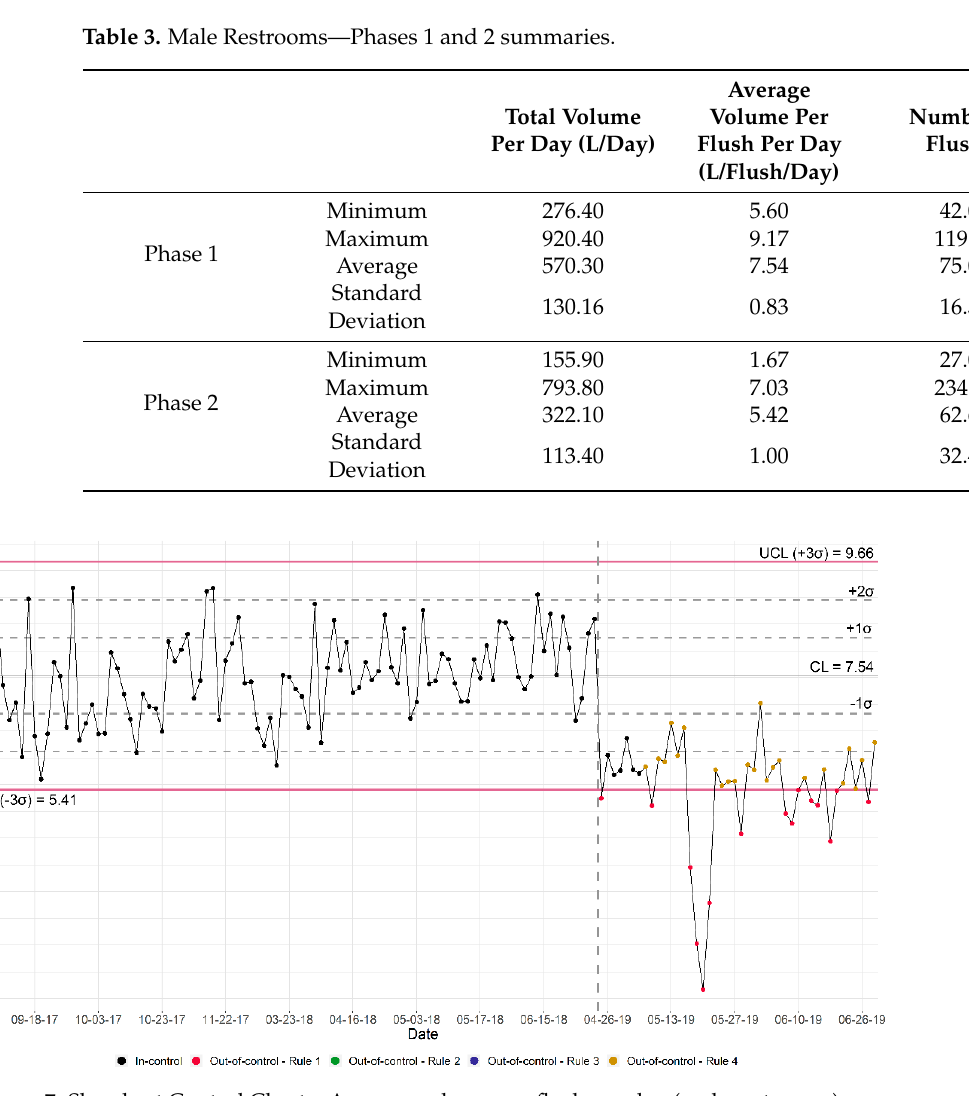
Figure 8. Shewhart Control Chart—Average volume per flush per day (female restrooms). Regarding the assumptions, Phase 1 average volume per flush per day data showed adherence to the normal distribution: men’s restrooms ( p -value = 0.3353) and women’s restrooms ( p -value = 0.1225). Furthermore, the data did not show autocorrelation: men’s restrooms average volume per flush per day ( p -value = 0.08055); women’s restrooms av- erage volume per flush per day ( p -value = 0.1304). The average total volume per day in Phase 2 for the men’s restrooms was 322.10 L/day, with an average of 62.68 flushes per day, while in the women’s restrooms, the average total volume per day, also for Phase 2, was 614.70 L/day with an average of 116.52 flushes per day. This difference strongly indi- cates the impact that urinals have on reducing the overall usage of toilets. Regarding water consumption patterns in women’s and men’s restrooms, Talpur et al. [50] mentioned that there were significant differences, since in men’s rooms there were toilets and urinals, while in women’s there were only toilets. In the study developed by Horsburgh et al. [49], the results showed that women used approximately twice as much water as men per restroom visit. The authors attributed this mainly to the fact that men’s rooms offered urinals. The authors found urinal utilization rates 593% higher than toilet utilization rates (plumbing fixture flush per restroom user).